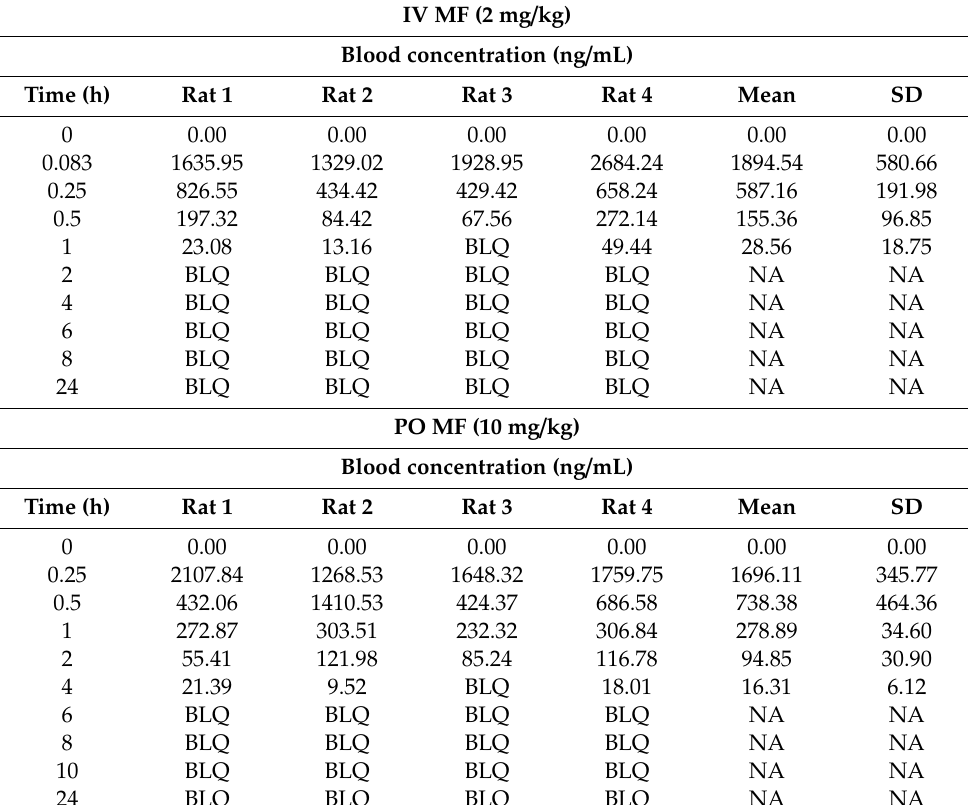
Table 2. Plasma MF concentration in SD rats.